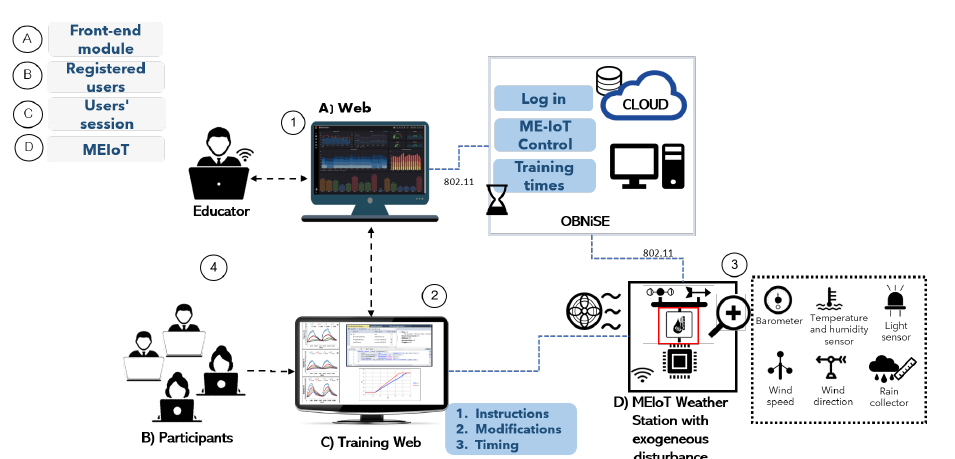
Figure 1. National Digital Observatory of Smart Environments (OBNiSE) Internet of Things (IoT) architecture for Educational